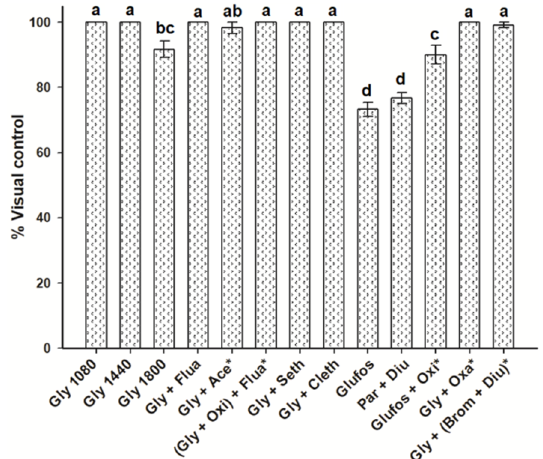
Figure 3. Control of Echinochloa colona in the Persian lime grove “San Manuel II” of the “San Manuel” Farm, Puebla, Mexico, at 75 days after treatment. Same letter shows no differences between treatments by the Tukey test ( P > 0.05). Vertical bars ± standard error from combined data of field trials carried out in 2014 and 2015 ( n = 6).